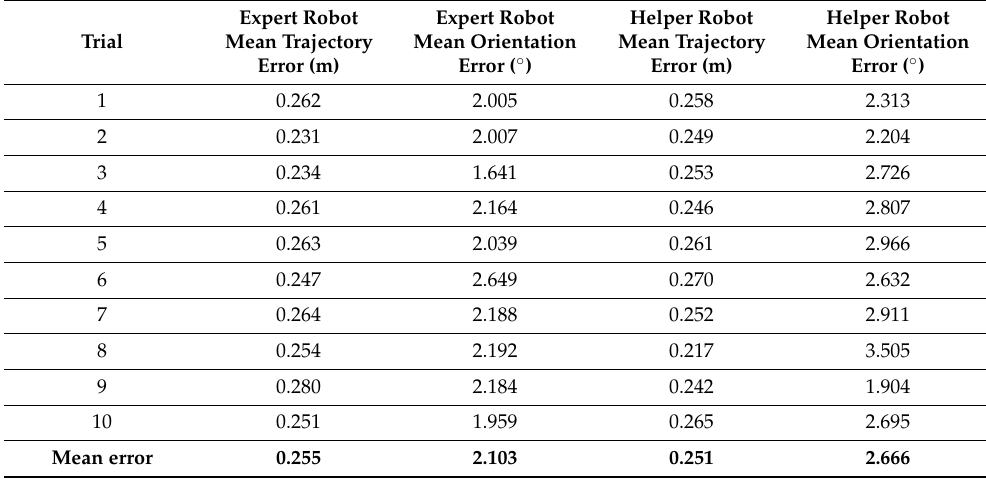
Table 3. Position and orientation errors for the expert and helper robots for the second test path.